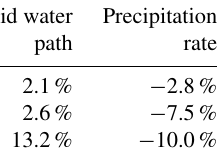
Table 4. Relative difference ((AE10 − AE1) / AE1) of modeled liq- uid water path and precipitation rate in average for the three areas: (Area-9–11N) from 9 to 11 ◦ N, (Area-7–9N) from 7 to 9 ◦ N, and (Area-5–7N) from 5 to 7 ◦ N, and extending from 1 to 4 ◦ E. Liquid water Precipitation path rate Area-9–11N 2.1% − 2.8% Area-7–9N 2.6% − 7.5% Area-5–7N 13.2% −